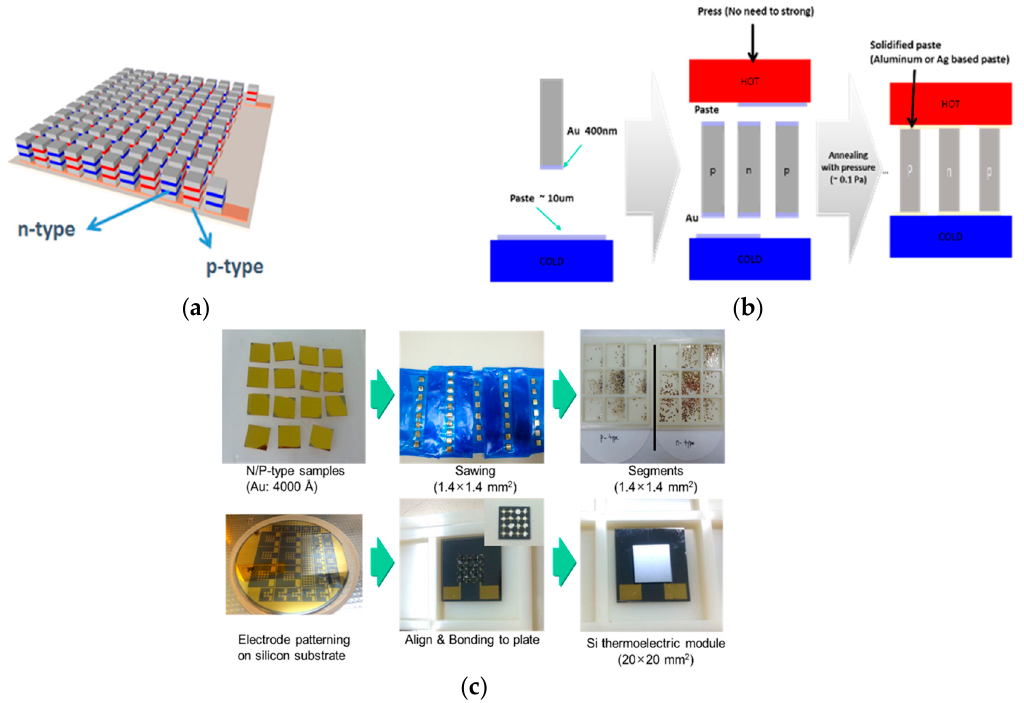
Figure 4. ( a ) The 3D thermoelectric module based on Silicon and ( b ) the fabrication overview. ( c ) Fabrication process details of the thermoelectric module.